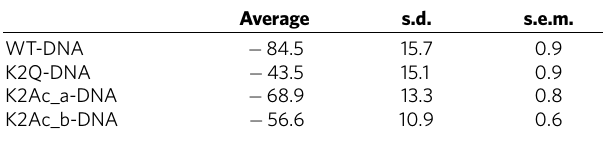
s.d., standard deviation; s.e.m., standard error of the mean; WT, wild type. Calculated MM/PBSA protein–DNA-binding free energies (kcalmol (cid:2) 1 ) based on 3ns MD